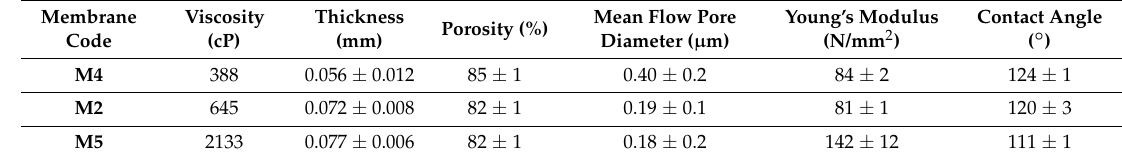
Table 2. Membrane characterization of membranes prepared at different polymer content.